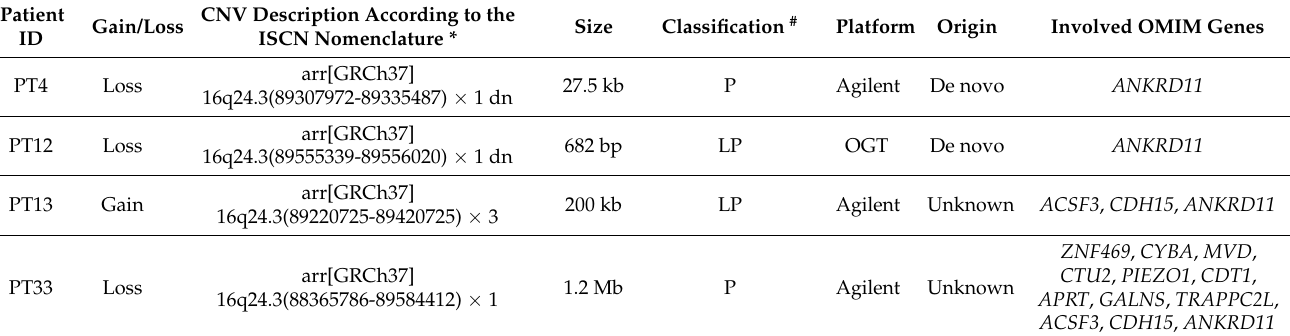
Table 2. Copy Number Variants identified through CMA analysis in the KBG